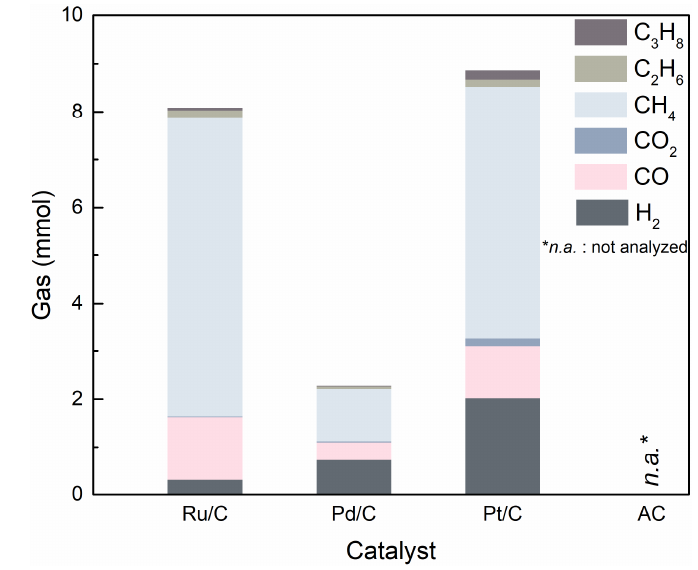
Figure 5. The amount and distribution of gas phase products after the decomposition of BPE at 270 °C, 4 h in supercritical ethanol.